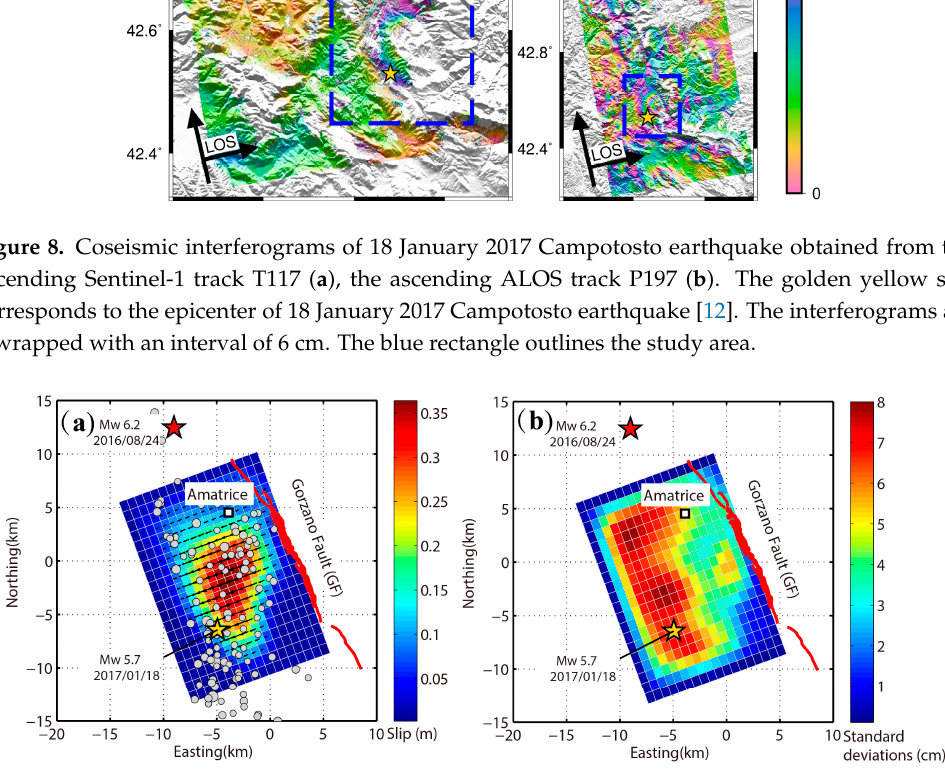
Figure 9. ( a ) Surface projection of the coseismic slip model of 18 January 2017 Campotosto earthquake. ( b ) Standard deviations in slip from Monte Carlo estimation with 100 perturbed datasets. Red line represents the active fault. Gray dots denote the aftershocks of ML > 3 from 18 January 2017 to 30 June 2017 [12]. Color shows the slip magnitude in meters, and arrows correspond to the slip directions. White square denotes the city of Amatrice. The red star corresponds to the epicenter of 24 August 2016 Amatrice earthquake and the golden star corresponds to the epicenter of 18 January 2017 Campotosto earthquake [12].